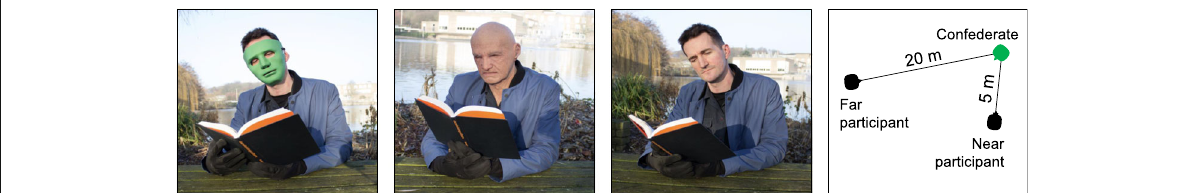
Fig. 4 Illustration showing (from left to right) author RJ in the Low-realism mask , High-realism mask and Real face conditions of Experiment 3, and the spatial arrangement of confederate and participants